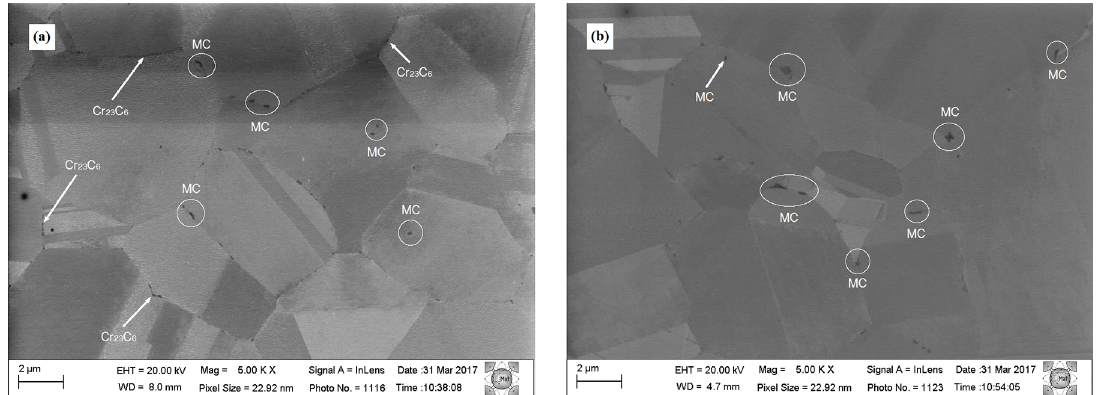
Figure 5. Images obtained by detection of secondary electrons from regions with precipitates previously identified by EBSD (a) MC and M C precipitates and (b) MC precipitate found. 23 6